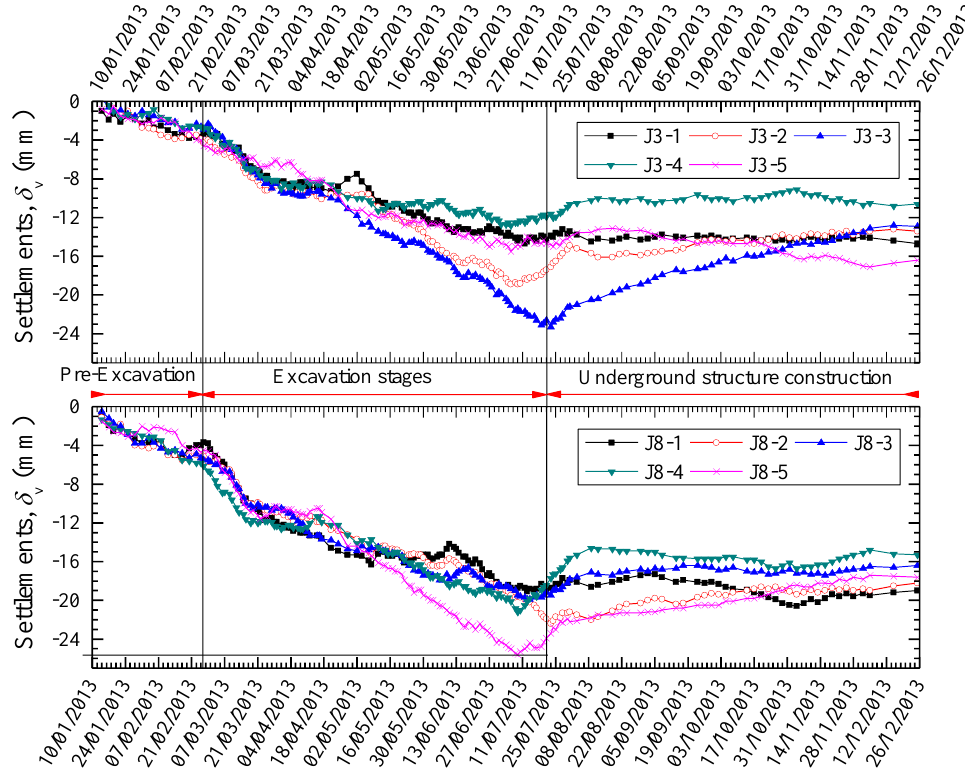
Figure 12. Developments of the ground settlements at J3-1 to J3-5, and J8-1 to J8-5.